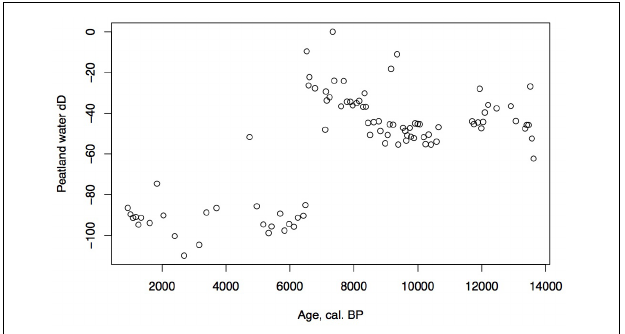
FIGURE 8 | D / H ratios of peatland water for Phalarope Pond, Kodiak Island.